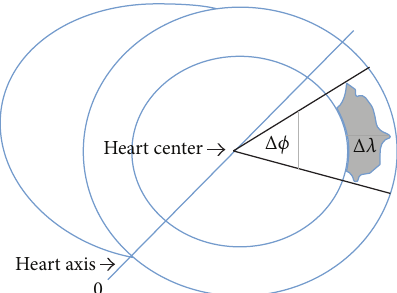
Figure 2: Diagrammatic drawing of scar measurements. Most patients have 6–9 slices, and the drawing is a transversal cut of right and left ventricle of one slice. The phase 𝜙(𝑥) of any pixel 𝑥 is defined as the angle (ranging from 0 to 360 ∘ ) between the line joining the pixel and the heart center and the heart axis. The endocardial extent of infarction (Δ𝜙) of a scar is drawn through the part of the scar with the shortest and longest phase as shown in the scar of the drawing. The radial position, 𝜆(𝑥) , of any pixel 𝑥 within the myocardium is a numberbetween0and1representingtherelativedistancewithinthe myocardialborders.0representsendocardiumand1epicardium. Δ𝜆 is defined as the distance between 𝜆 = 0 and maximum 𝜆 . Only scars adherent to endocardium with 𝜆 = 0 are used in the current